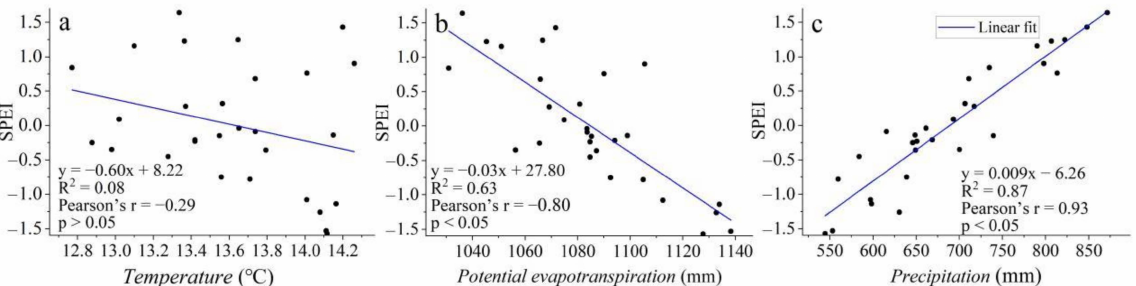
Figure 12. Relationship between annual mean temperature ( a ), potential evapotranspiration ( b ), precipitation ( c ) and annual